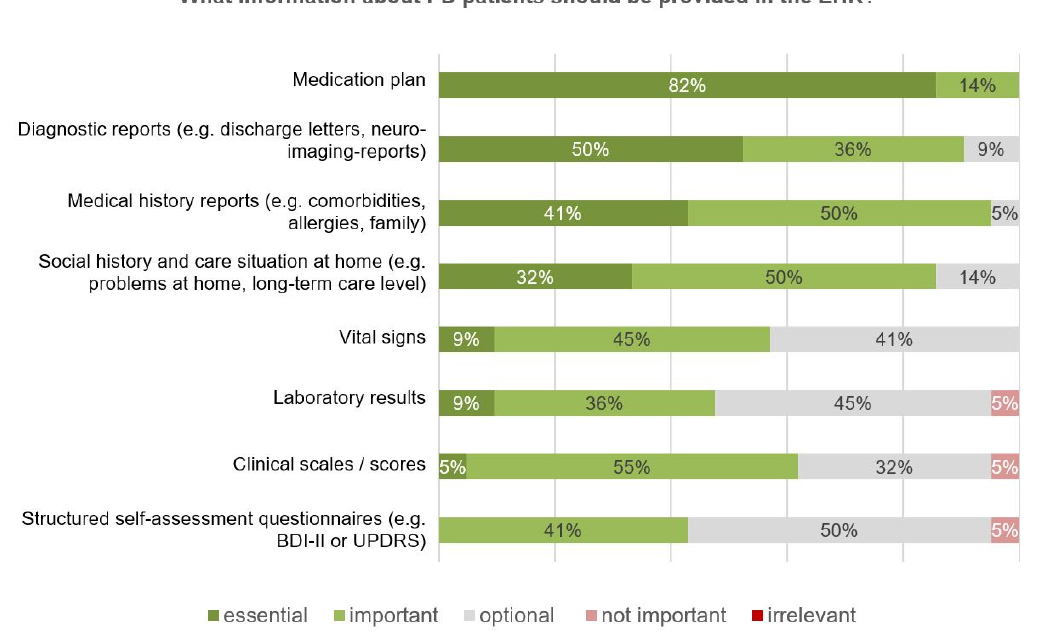
Table 5. Results of TED voting—electronic health record.